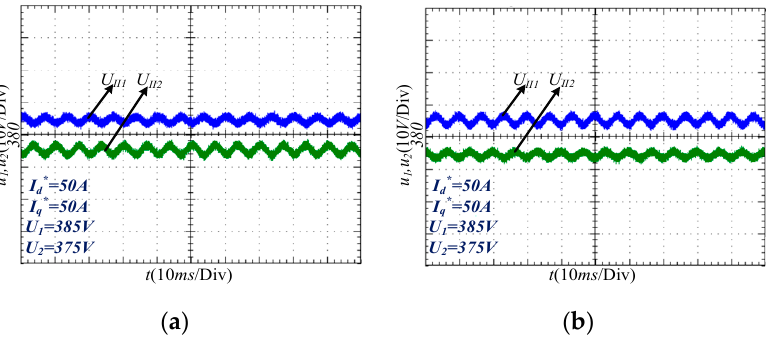
Figure 18. Waveforms of U 1 and U 2 with an additional capacitor. ( a ) Connected from P 2 to O 2 . ( b ) Connected from N 2 to O 2.